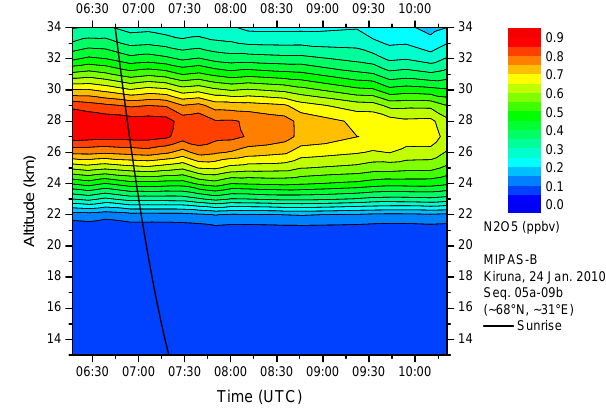
Fig. 13. N 2 O 5 mixing ratios as measured by MIPAS-B on 24 January 2010 above northern Scandinavia. For details, see text.